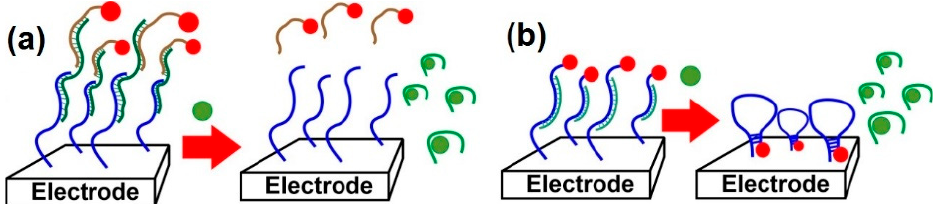
Figure 6. Label-based detection of antibiotics by electrochemical aptasensors: ( a ) aptamer is partially complementary to capturing DNA attached to the electrode and signaling DNA-bearing label. In- teraction with analyte releases aptamer–analyte complexes, and this results in removal of labeled DNA from the electrode interface; ( b ) aptamer forms duplex with partially complementary DNA attached to the electrode and modified with label at its opposite end. Interaction with analyte removes aptamer from the duplex and allows DNA to convert to hairpin configuration with label near the electrode surface.